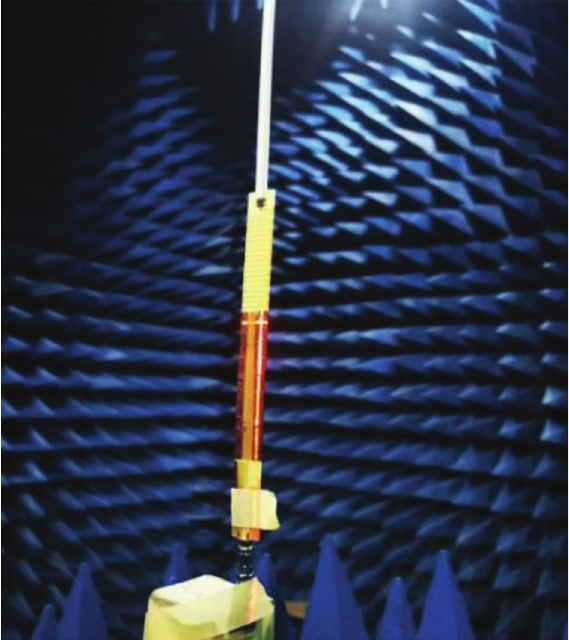
Figure 8: The environment of measured UAV